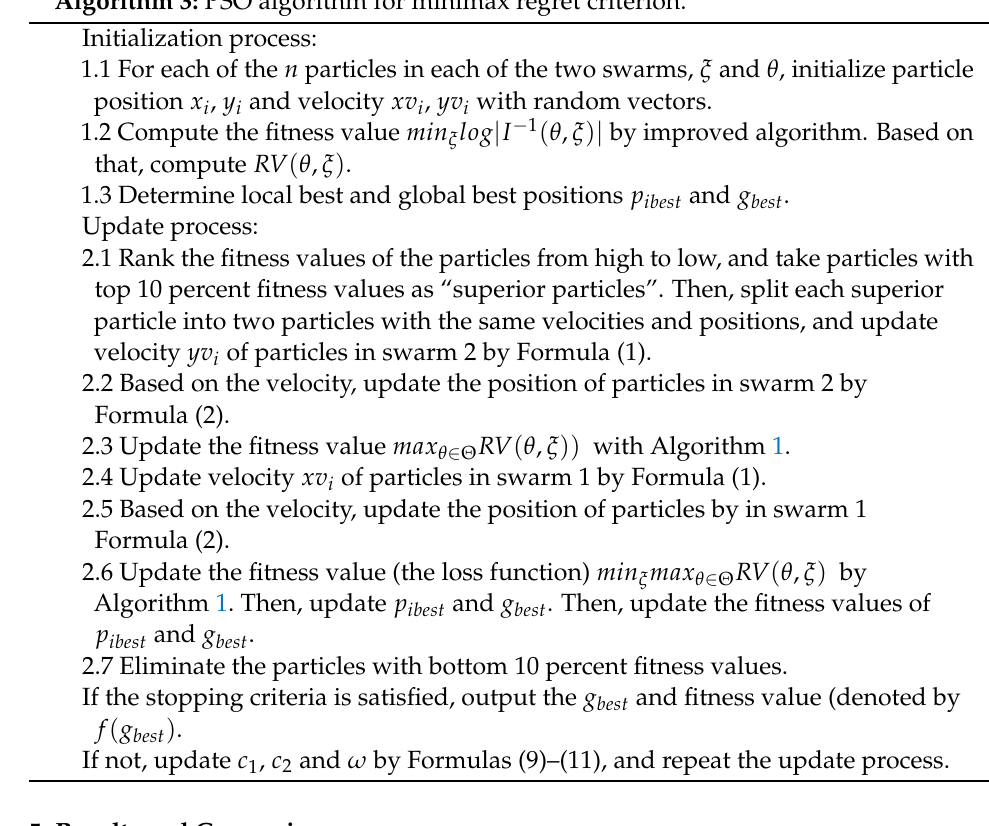
Algorithm 3: PSO algorithm for minimax regret criterion.